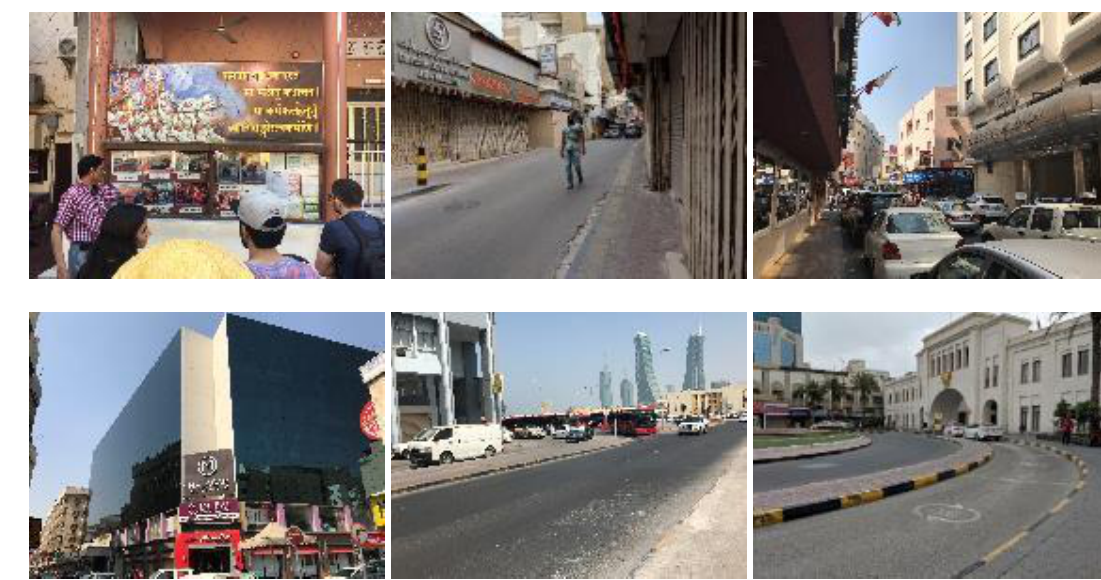
Figure 10. The common social and commercial Activities in the case study area